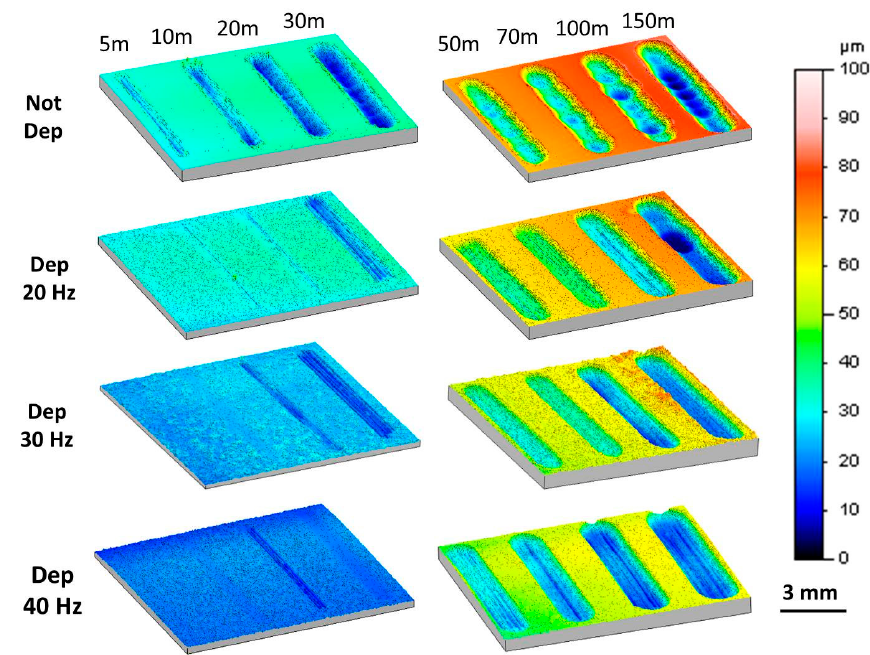
Figure 14. 3D maps of the wear tracks.